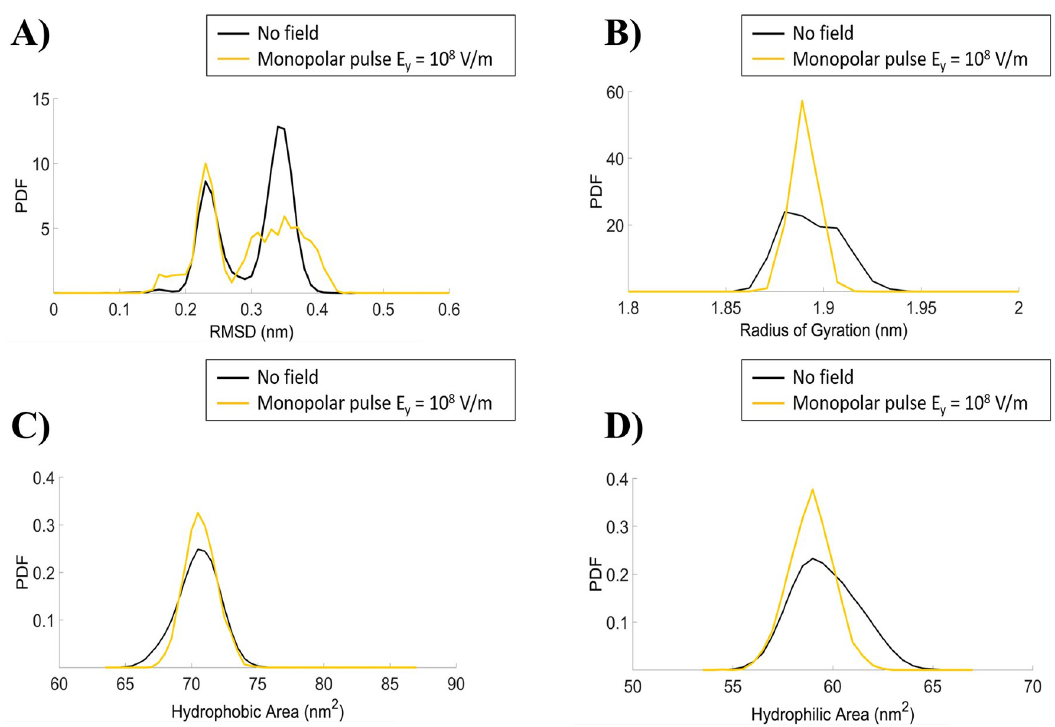
Fig 5. MD simulations observables. In the panel four different protein observables are presented as probability density distributions: the RMSD (A), the Radius of gyration (B) and the Hydrophobic (C) and Hydrophilic (D) areas. The curves refer to the protein structure in equilibrium condition (black line) and under the effect of external MP of 10 8 V/m intensity (yellow